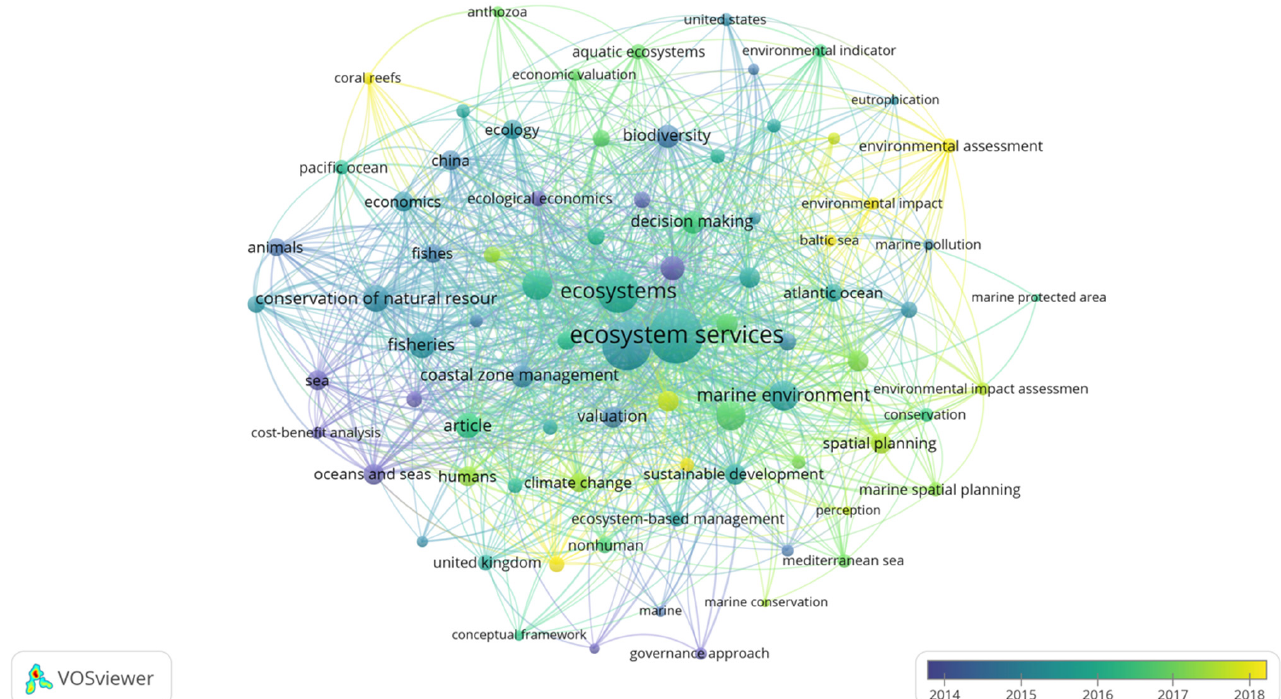
Figure 1. Keywords related to “marine ecosystem services” in the scientific literature, represented on the basis of the average year of publication of documents in which they occur, on a color gradient from blue (older publications) to green (publications equally distributed across the timespan) and yellow (more recent publications).